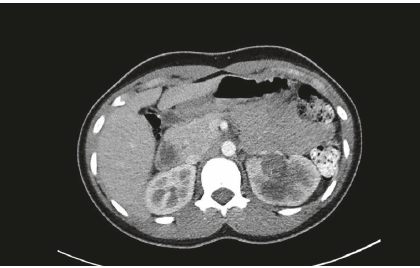
Figure 1: Abdominal computed tomography scan reveals a mass in the left pelvicalyceal system with associated moderate to severe hydronephrosis.